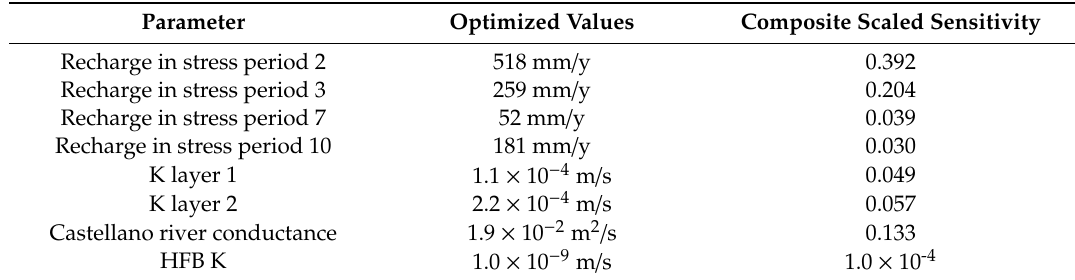
Table 3. Results of the sensitivity analysis with